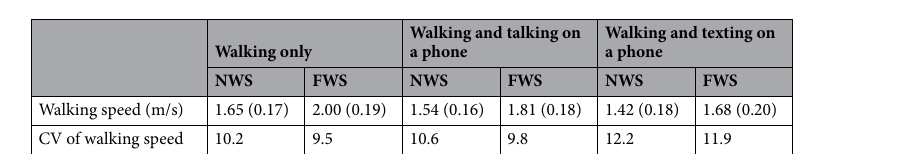
Figure 3. Mean maximum Lyapunov exponents when walking at self-selected normal (NWS) and fast walking speed (FWS), while texting on a mobile phone, talking, or performing no concurrent task (walking only). Black bars = anteroposterior axis, White bars = vertical axis, Grey bars = mediolateral axis. ‘*’ denotes a statistically significant effect of walking speed instruction. ‘t’ denotes a statistically significant effect of task.